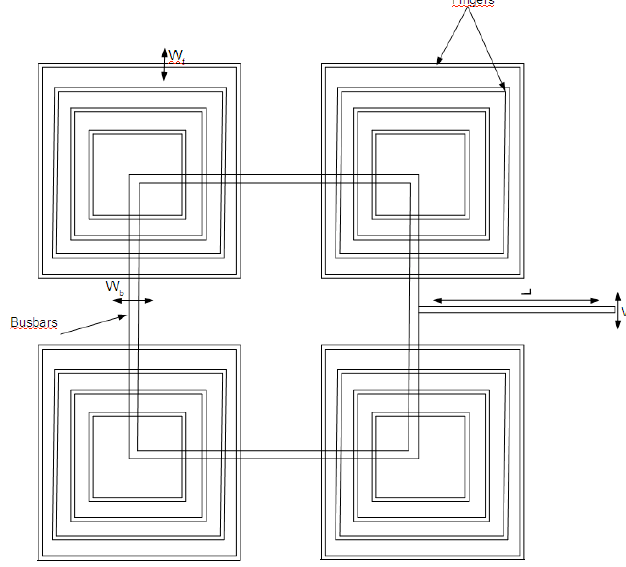
Figure10. Patch antenna proposed